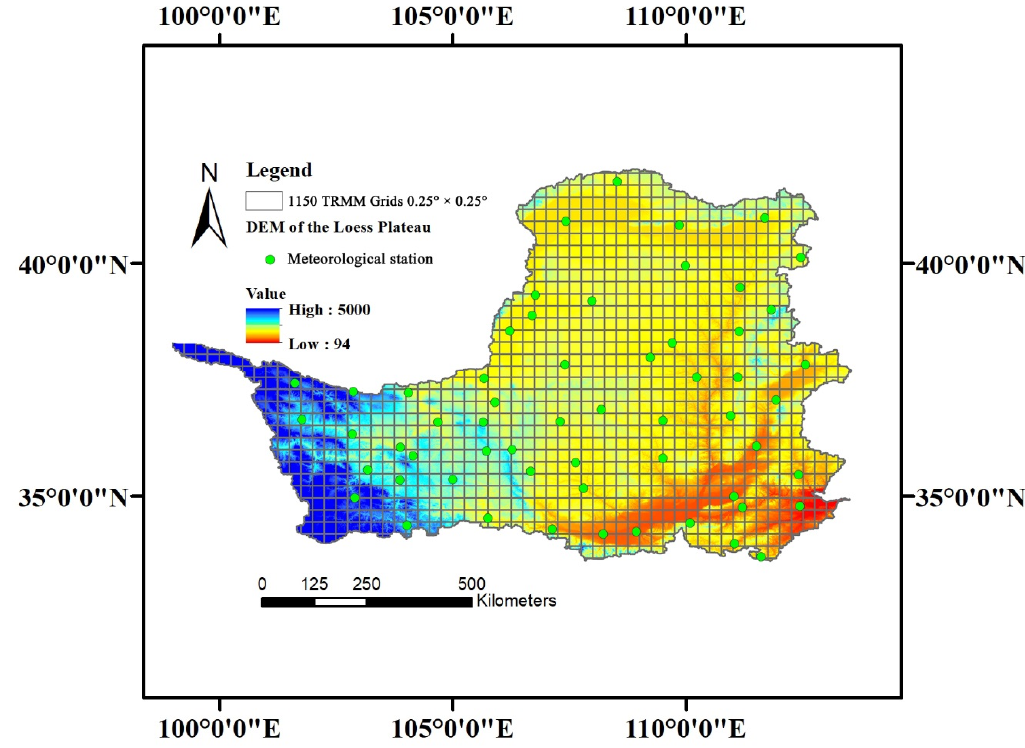
Figure 1. The location of the Loess Plateau and the distribution of the meteorological stations.